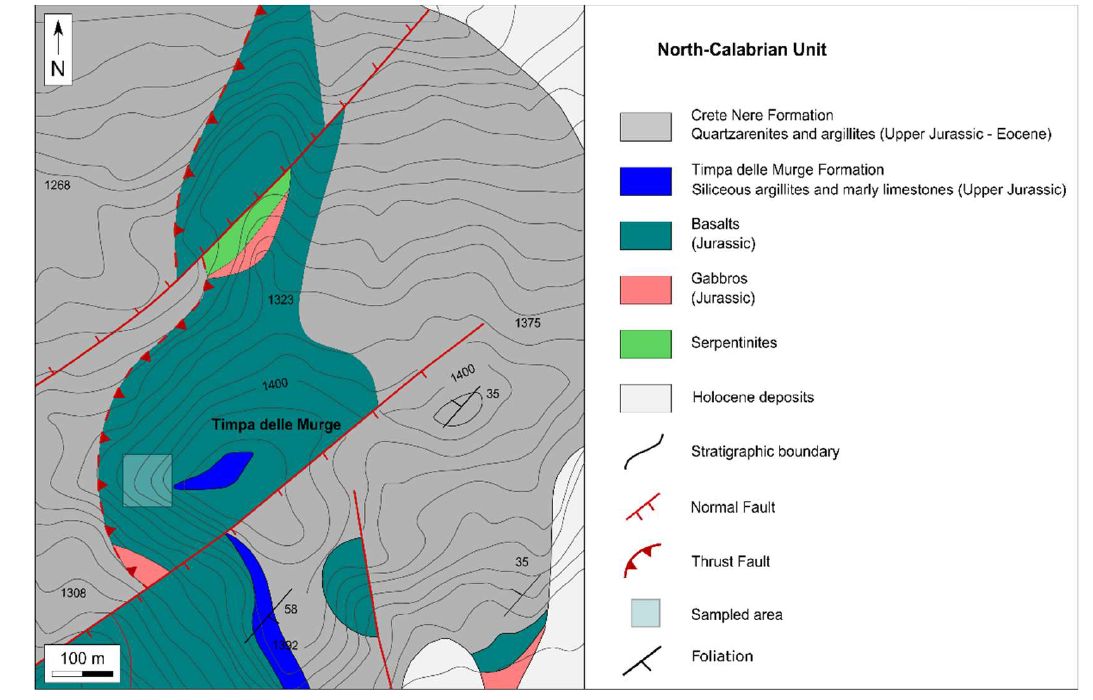
Figure 2. Geological schematic map of sampled area (Timpa delle Murge). Scale 1:10,000 (modified after [44]).